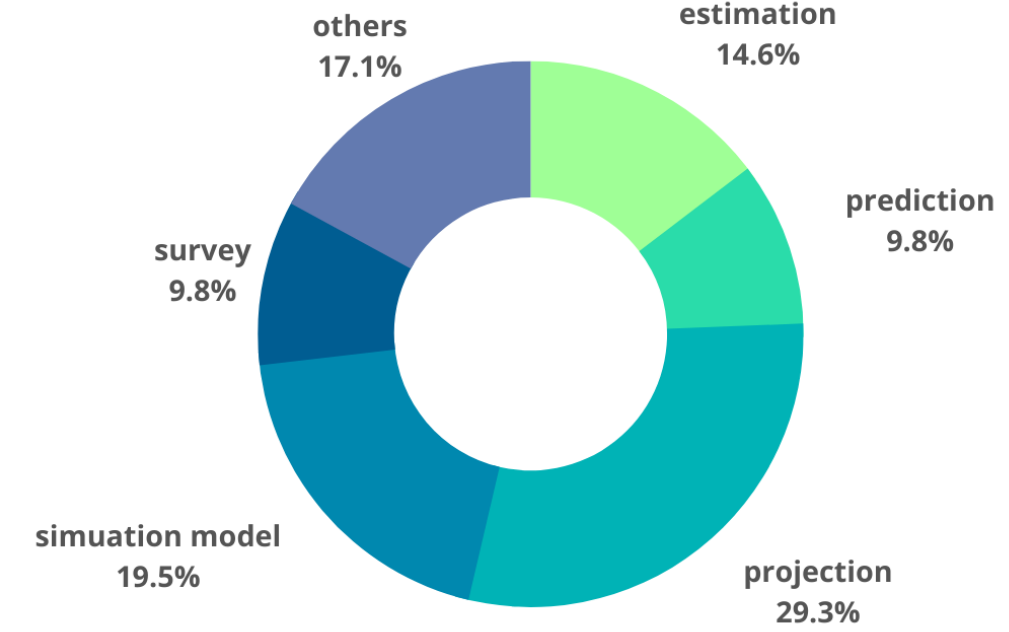
Figure 4. Methods, tools, and procedures identified in empirical